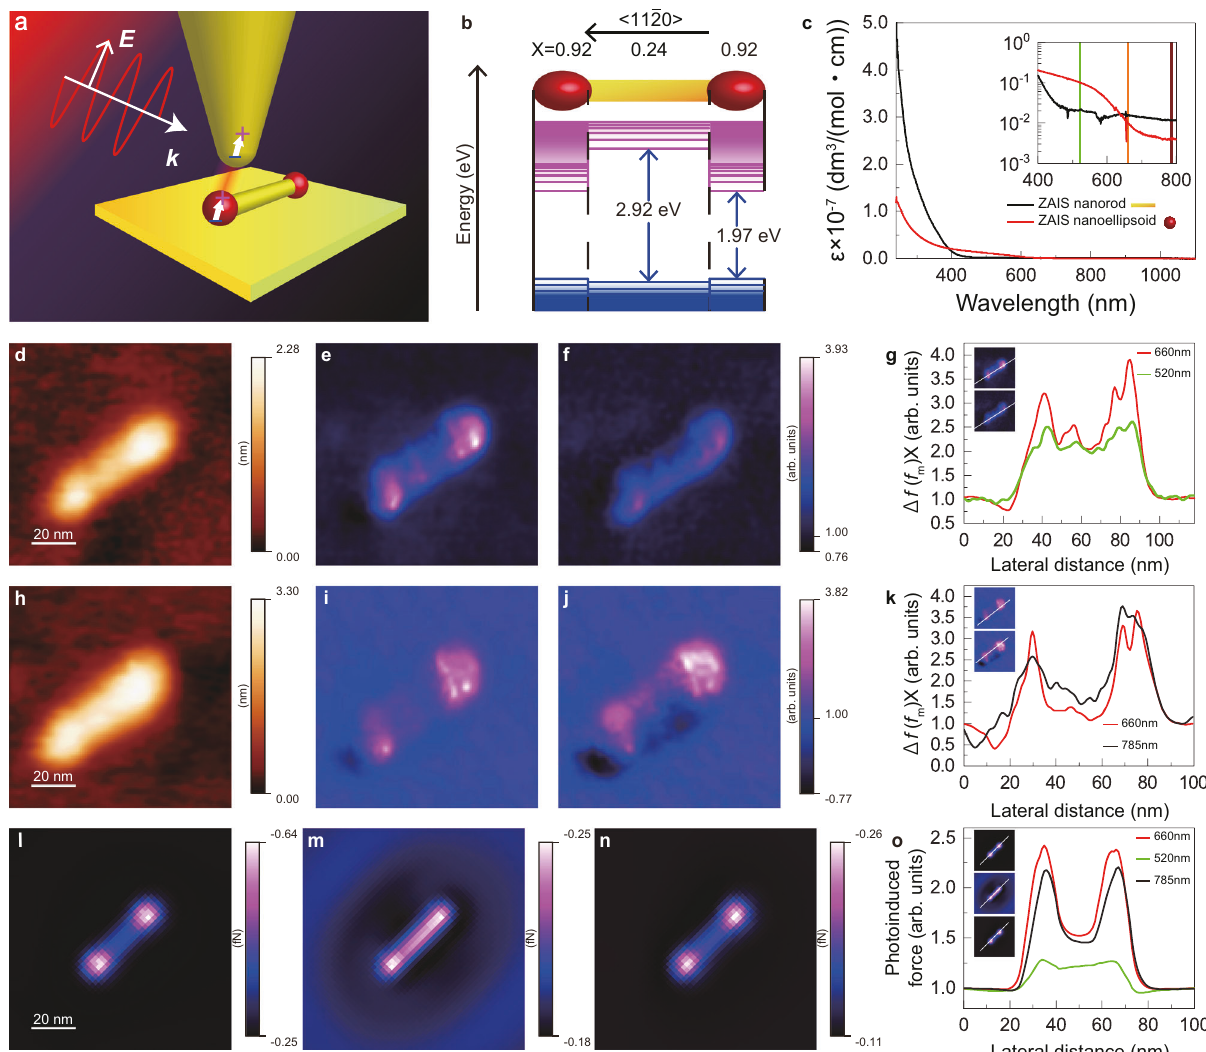
Fig. 1 Simultaneous PiFM measurements performed using two different wavelengths. a Schematic diagram of PiFM under UHV in a side-illumination con fi guration. Here, E and k are the electric fi eld and wave number vector, respectively, of the incident light. b Model of a dumbbell-shaped ZAIS QD and structure of its electronic states. x re fl ects the composition of the ZAIS QD as described by the formula (AgIn) x Zn 2(1 − x ) S 2 . The band gaps of the nanoellipsoids and nanorod are approximately 1.97 and 2.92 eV, respectively. c Molar absorption coef fi cient ( ϵ ) dispersion at the end and in the middle of a ZAIS QD. d , h AFM images of a ZAIS QD on a gold surface. e , i PiFM images acquired at λ = 660 nm. f , j PiFM images acquired at λ = 520 and 785 nm, respectively. d – f and h – j were acquired simultaneously. g Photoinduced force pro fi les for the images shown in e and f . k Photoinduced force pro fi les for the images shown in i and j . The positions at which the pro fi les were acquired are indicated in the insets. l – n Theoretically calculated photoinduced force images at λ = 660 nm, 520 nm, and 785 nm. o Line pro fi les of l – n in the insets. The photoinduced forces are normalised with respect to those on the gold